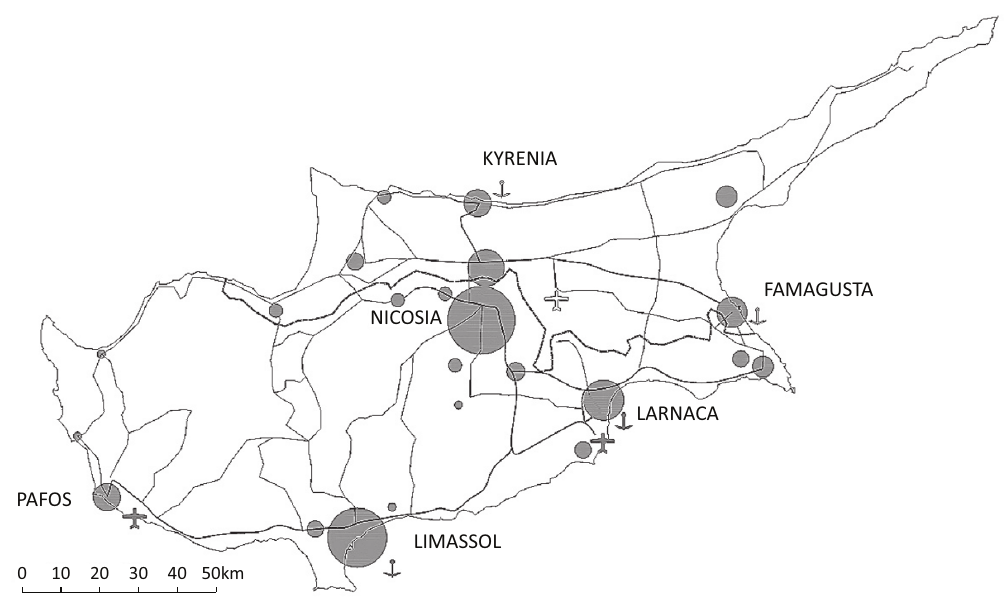
Figure 1. Map of Cyprus indicating Nicosia and the main settlements of the